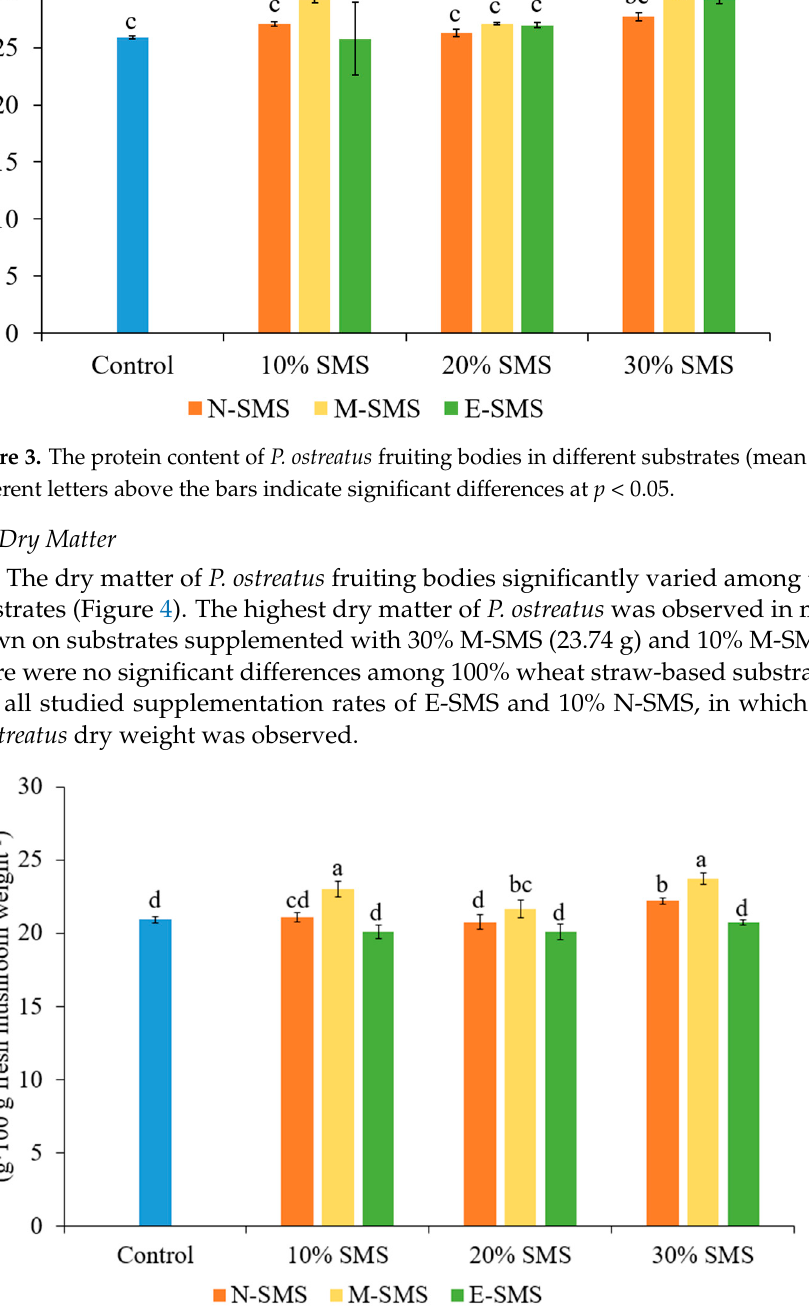
Figure 4. Dry matter content of P. ostreatus in different substrates (mean ± SD, n = 3). Different letters above the bars indicate significant differences at p < 0.05.